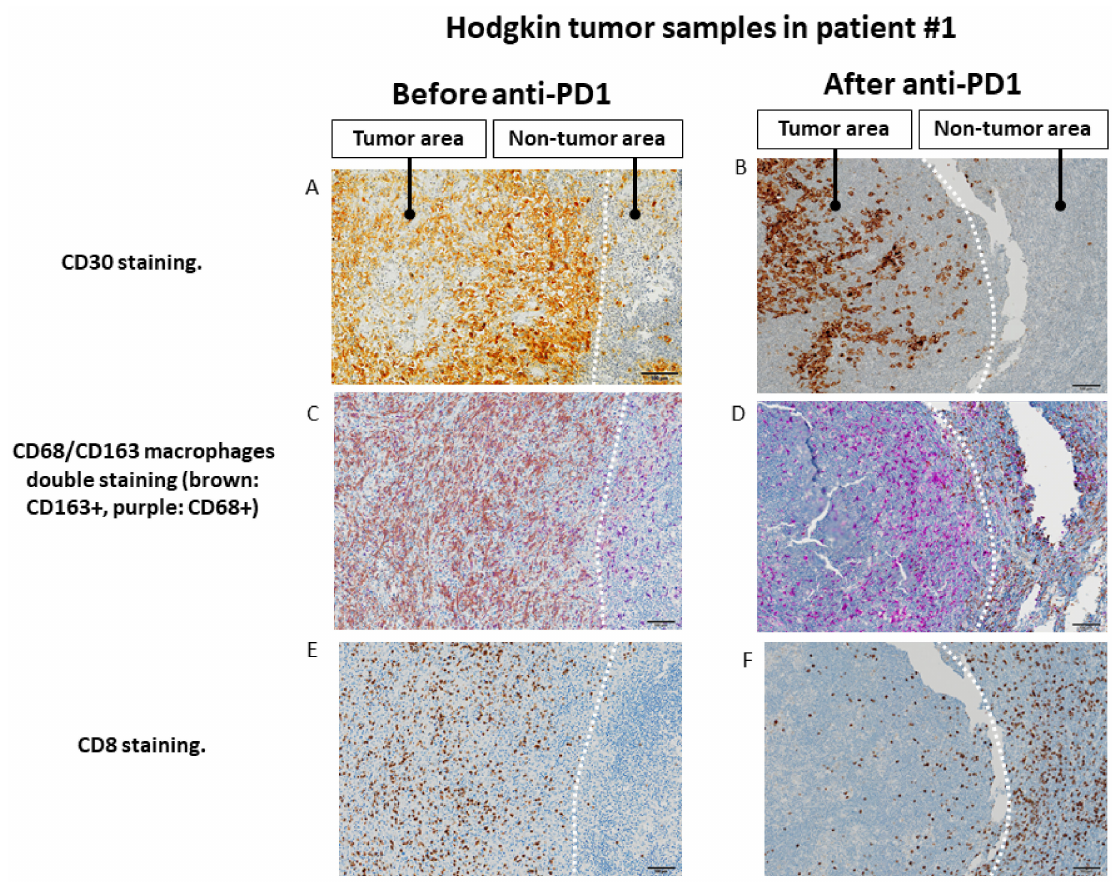
Figure 4. Changes in the spatial tumor distribution of CD8 lymphocytes and CD68/CD163 macrophages before and after anti-PD-1 immunotherapy by immunohistochemistry in samples from patient #1 (fresh tumor microenvironment cells analysis, part B study). ( A , B ): CD30 immunohistochemical staining showing tumor areas with CD30+ Reed Sternberg of Hodgkin cells, in contrast to residual adjacent non-tumor lymphoid tissue. ( C , D ). Before exposure to anti-PD-1, tumor area is infiltrated by predominantly CD163+ macrophages, whereas adjacent lymphoid tissue is infiltrated mainly by CD68+CD163 − cells. After exposure to anti-PD-1, macrophages in the tumor area show only a CD68+CD163 − phenotype, whereas CD163 macrophages seem to be excluded from the tumor zone. ( E , F ). Before exposure to anti-PD-1, the tumor zone is rich in CD8+ T lymphocytes. After anti-PD-1, the tumor area is depleted of CD8+ cells while the adjacent lymphoid tissue appears rich in CD8+ T lymphocytes. The scale bar on each image (lower right corner) is equal to 100 µ